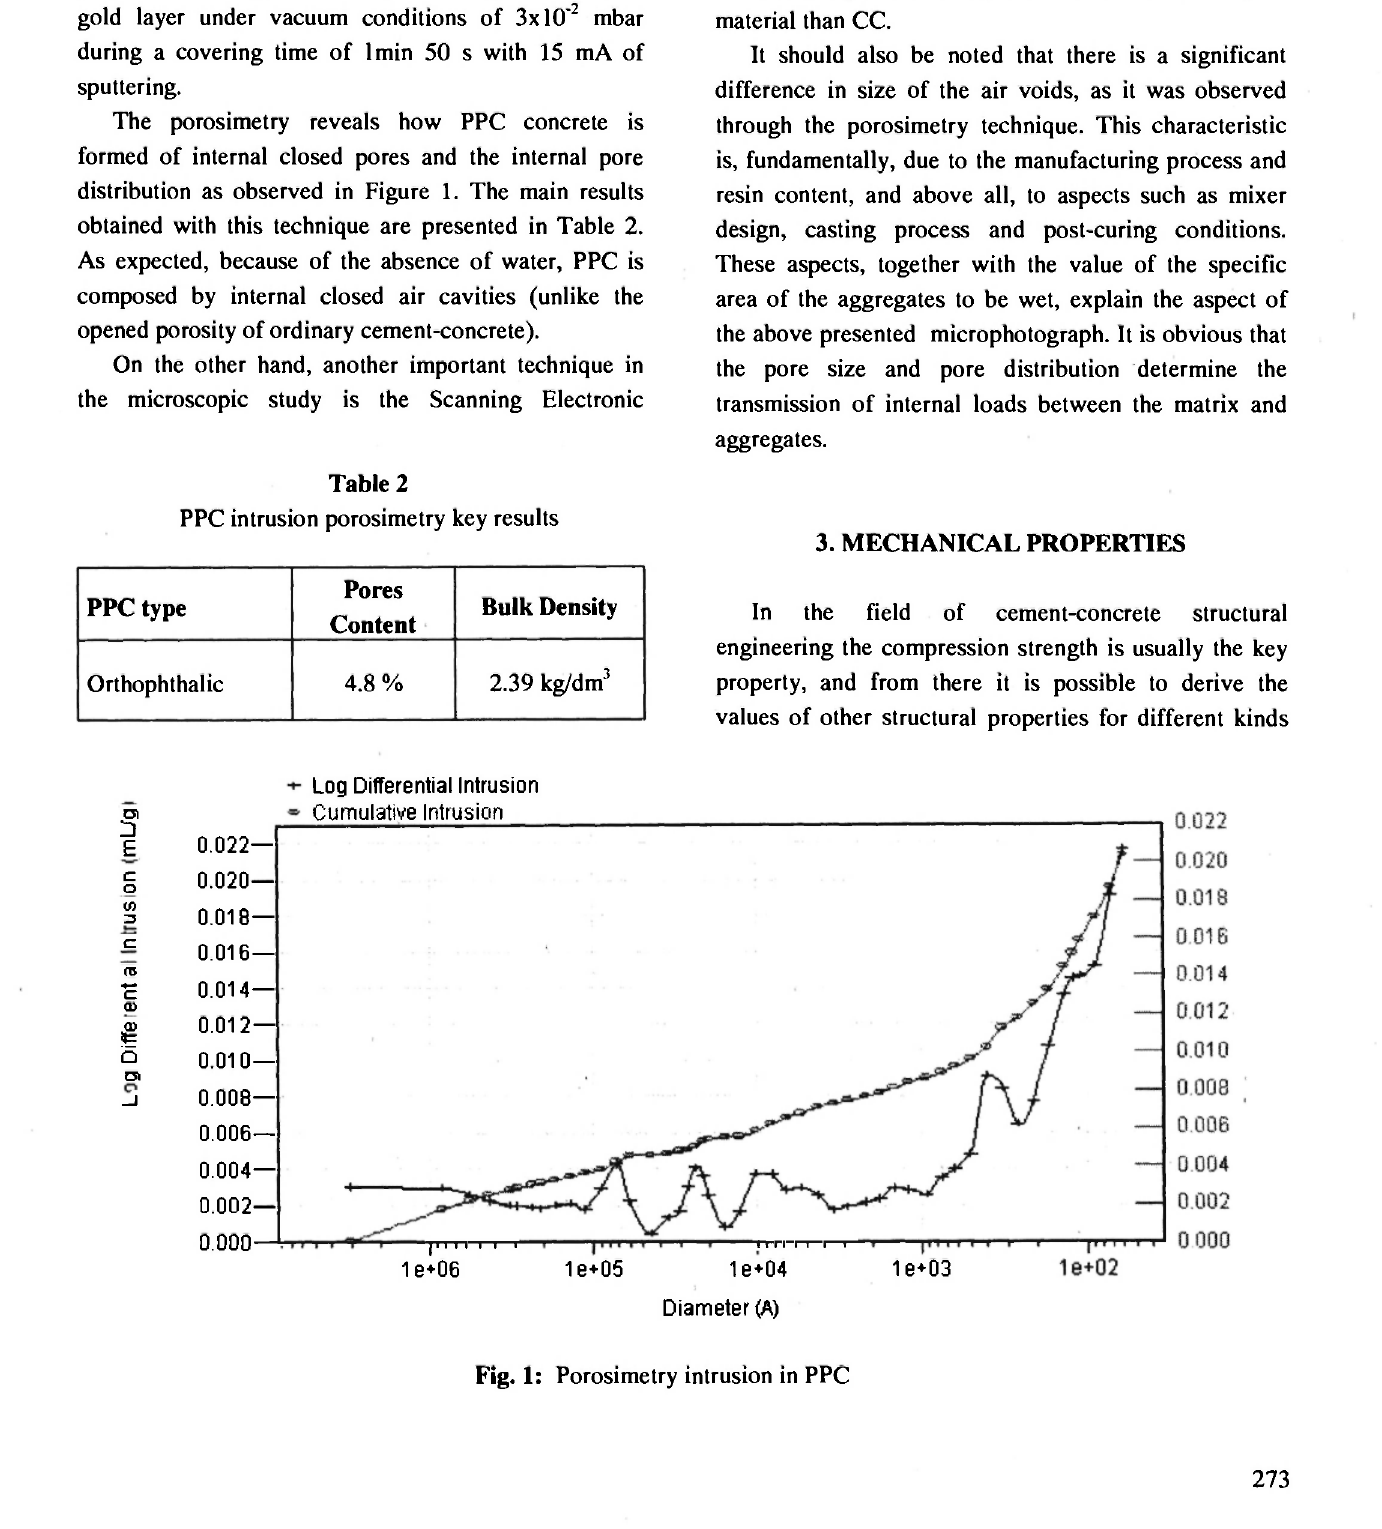
Fig. 1: Porosimetry intrusion in